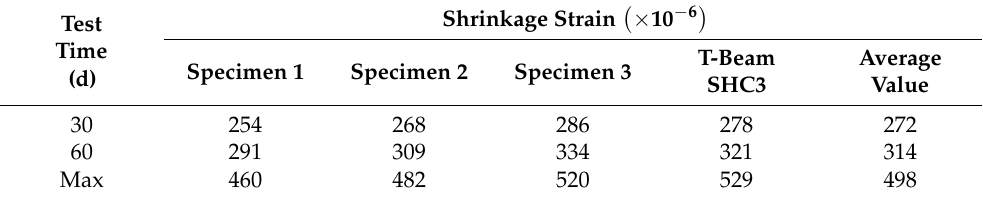
Figure 7. Time ‐ history plots of the shrinkage strain of various specimens (excluding the tempera ‐ ture effect). Table 3. Shrinkage strains at different times. Table 3. Shrinkage strains at different times.